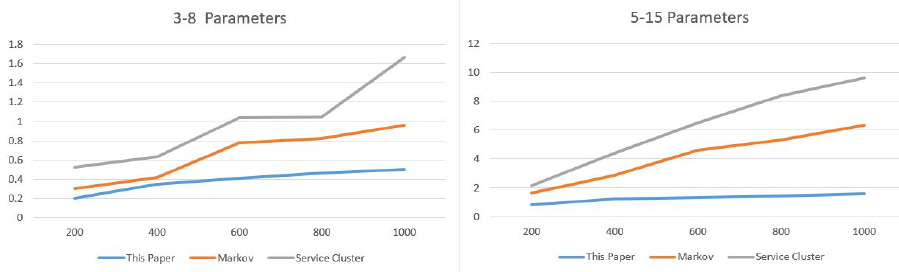
Figure 17. Comparison of execution